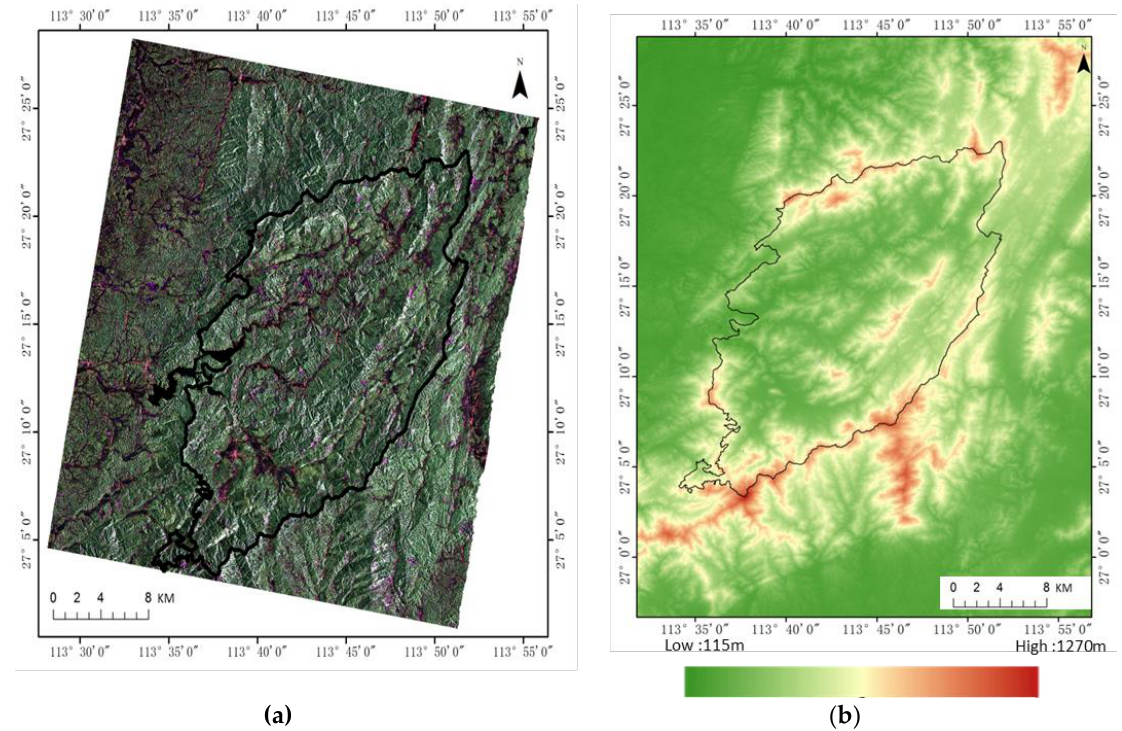
Figure 3. ( a ) The ALOS PALSAR-2 Pauli RGB composite image acquired on 30 June, 2016 and ( b ) digital elevation model (DEM) of the study area with the black line outlining the study area.